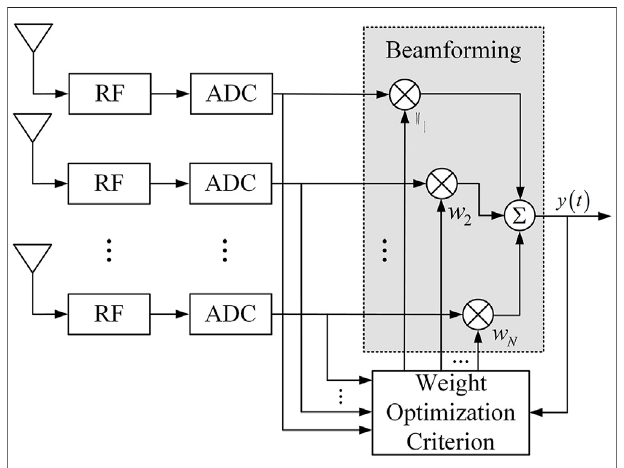
FIGURE 3 | Schematic diagram of antenna array spatial fi ltering.